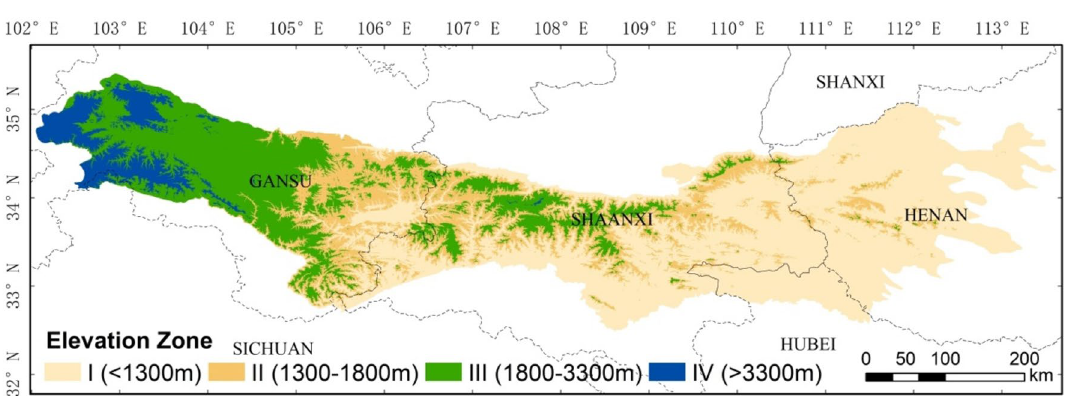
Figure 4. The spatial distribution of four Elevation Zone in Qin Mountains. According to the change rules of NDVI as the increased of elevation, we download DEM through GEE and divided the Qin Mountains into four Elevation Zones and mapping in the ArcGIS